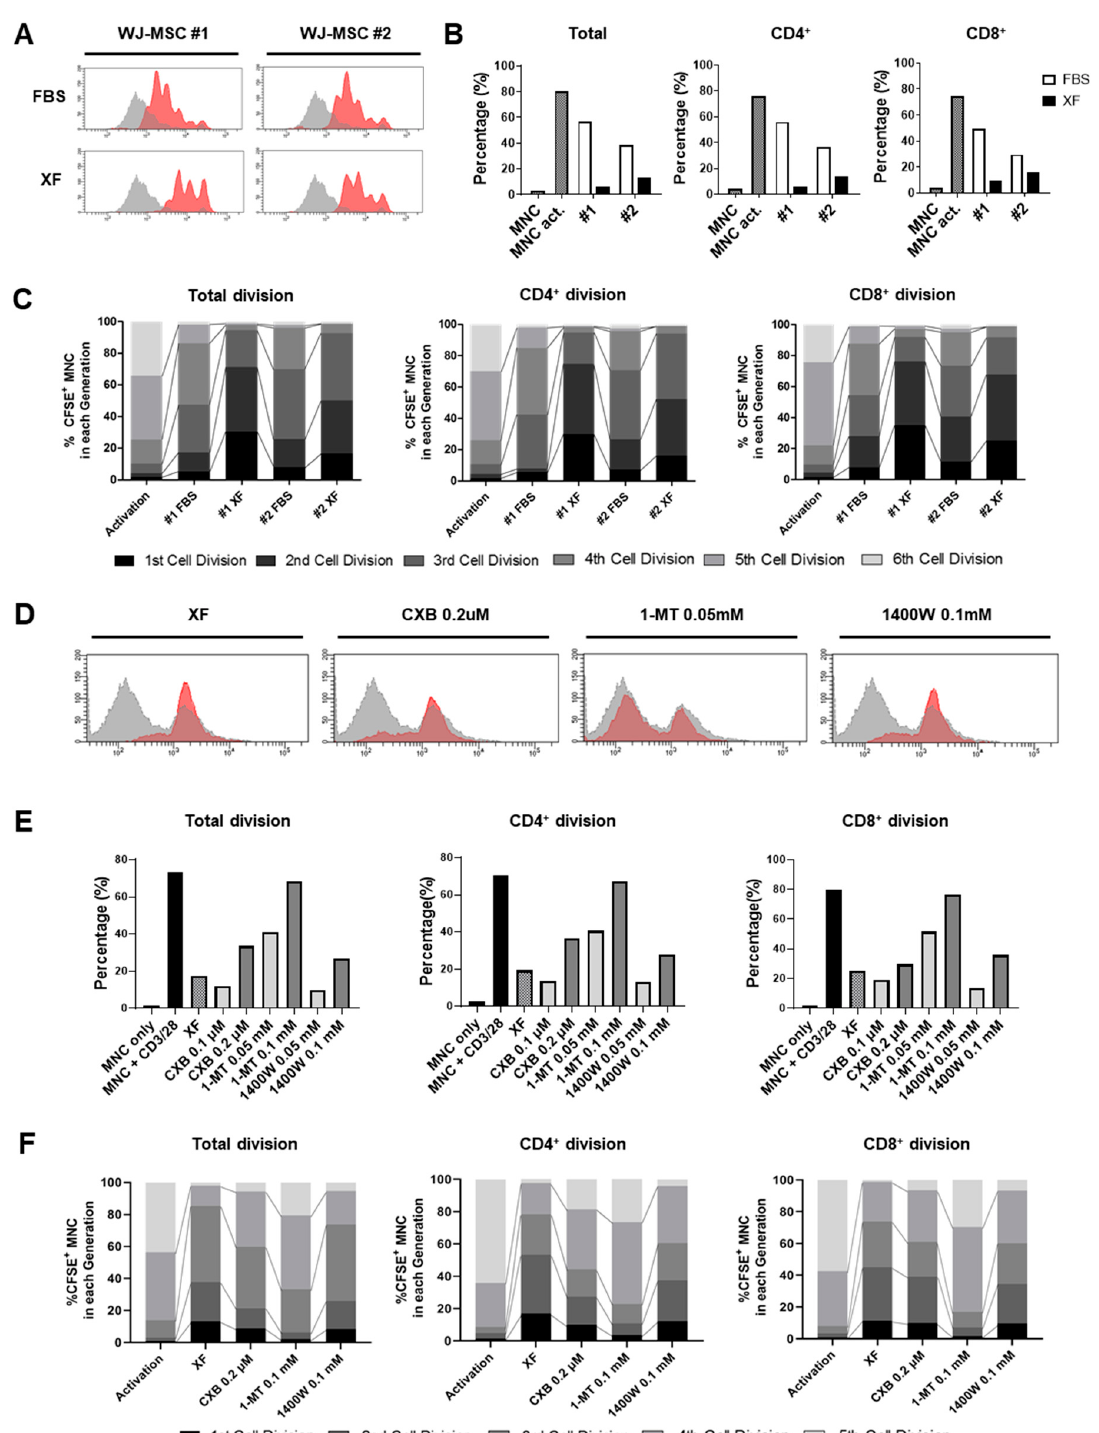
Figure 5. Long-term culture in XF conditions increases the immunomodulatory properties of WJ-MSCs. ( A – C ) Umbilical cord blood-derived mononucelar cells (UCB-MNCs) were stained with carboxyfluorescein succinimidyl ester (CFSE) and stimulated by anti-CD3 / 28 beads and IL-2 for T cell activation. Activated T cells were co-cultured with 10%-FBS or XF-MSCs. After 6 days, T cell proliferation was assessed in T subsets using flow cytometry. ( A ) Representative histogram of total T cell proliferation. ( B ) Proliferation rates of the total T, CD4 + T, and CD8 + T cells were quantified. ( C ) Cell divisions in the six distinct compartments were tracked using CFSE staining. ( D – F ) Peripheral blood mononuclear cells (PBMCs) were stained with CFSE and stimulated by anti-CD3/28 beads and